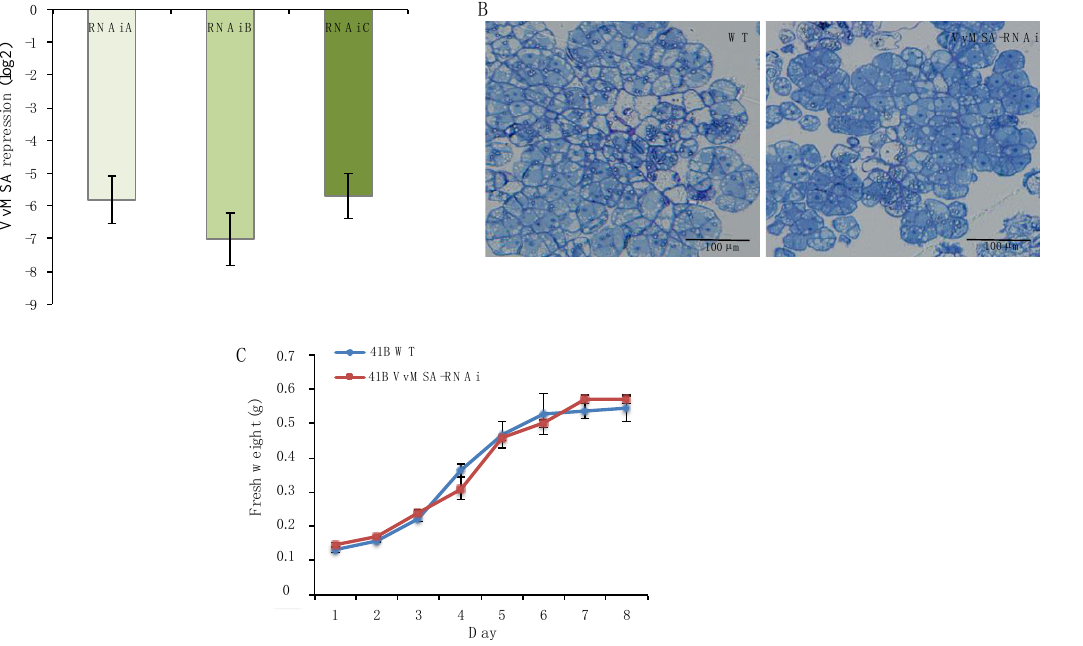
Figure 1. Phenotypic characterization of grape embryogenic 41B cells: wild-type and VvMSA -RNAi. ( A ) Real-time qPCR analysis of the grape ASR gene repression in three independent VvMSA -RNAi transgenic lines. The expression of each VvMSA -RNAi line was reported to that of the control wild-type cells (previously normalized to the reference VvACT gene). The repression of VvMSA was calculated by the 2 −∆∆Ct method, and presented as log2 fold change. The results correspond to the mean value and the standard error of three biological replicates for each cell line. ( B ) Cell morphology observation by light microscopy after toluidine blue staining (Olympus DP72): wild-type (left) and VvMSA -RNAi (right)). ( C ) Growth curves of wild-type cells (blue line) and VvMSA -RNAi transgenic cells (red